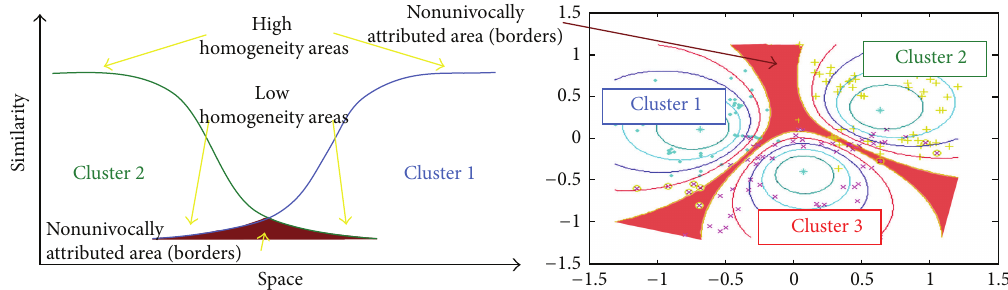
Figure 1: Infographic depicting the functioning of the